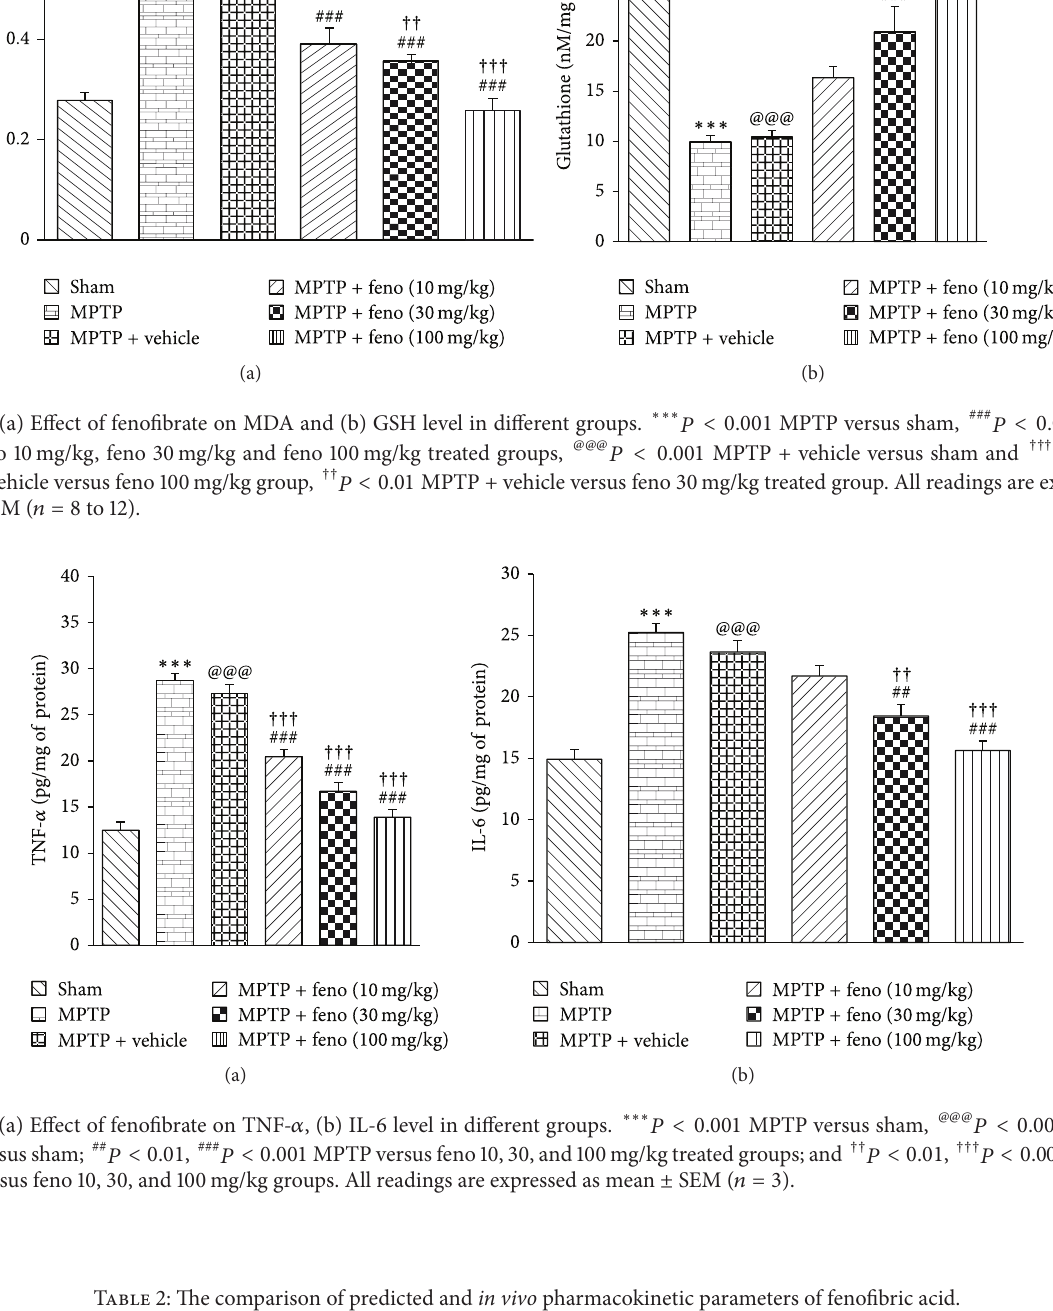
Table 2: The comparison of predicted and in vivo pharmacokinetic parameters of fenofibric acid. Sr.